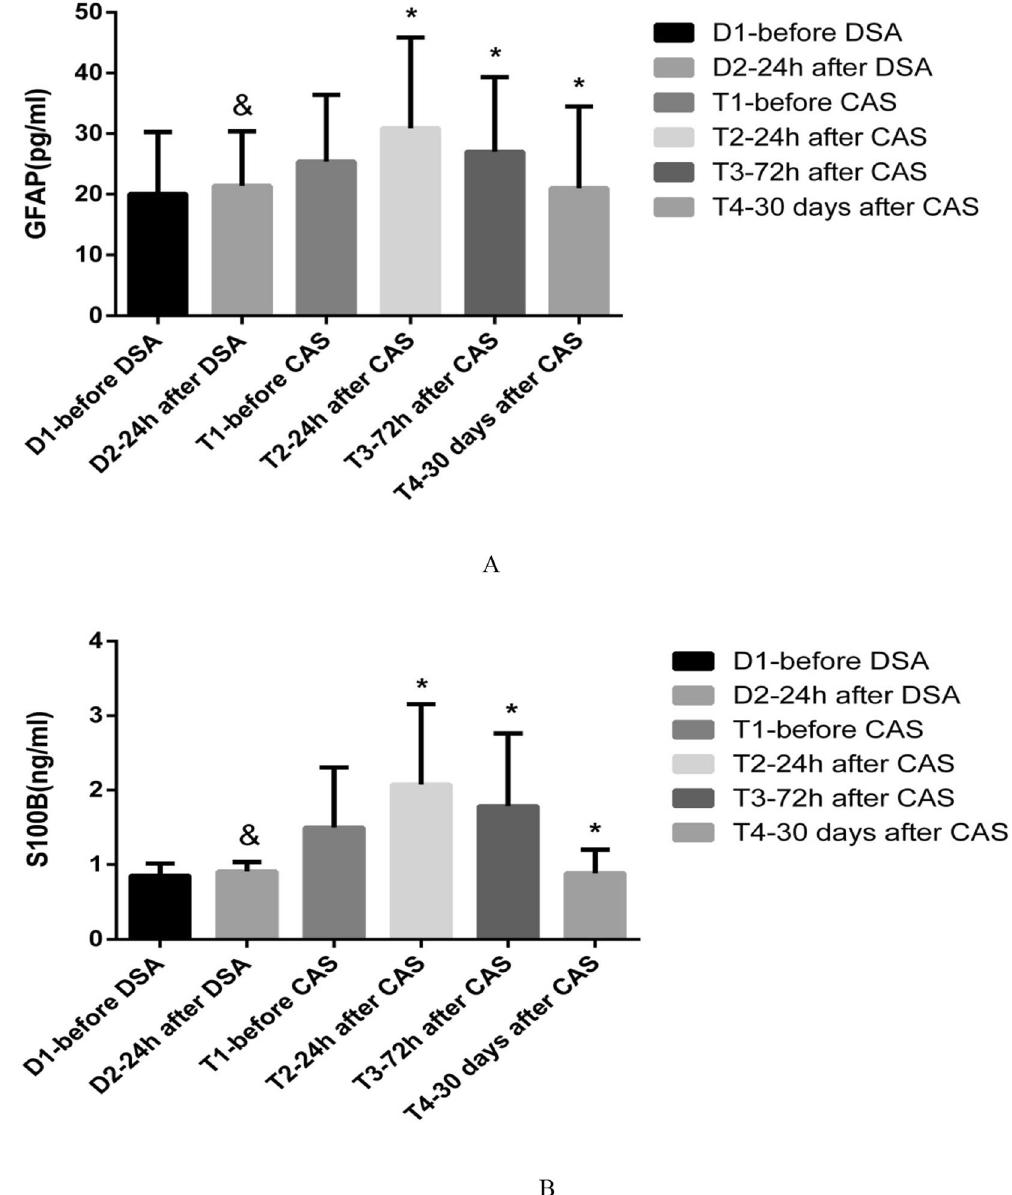
Figure 2. The serum concentrations of GFAP and S100B in patients in the control and operation groups The serum concentrations of GFAP ( A ) and S100B ( B ) did not change significantly after DSA ( & P > 0.05). After CAS, the serum concentrations of GFAP and S100B increased to the peak at 24 h after operation (T2), and then decreased gradually (T2 > T3 > T4; *P < 0.05).